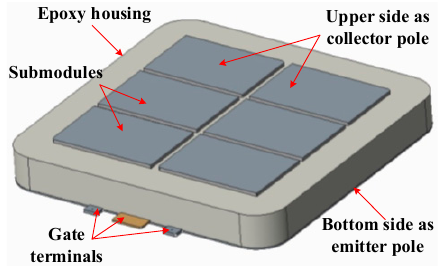
Figure 1. Appearance of press-pack IGBT module.